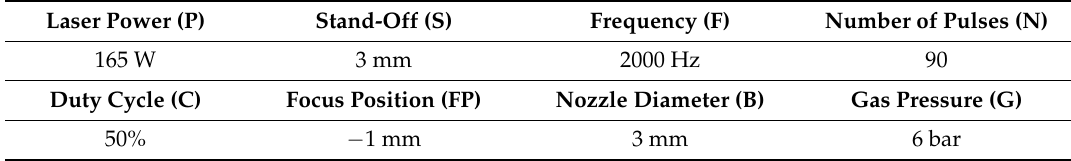
Table 5. Optimized values for the processing